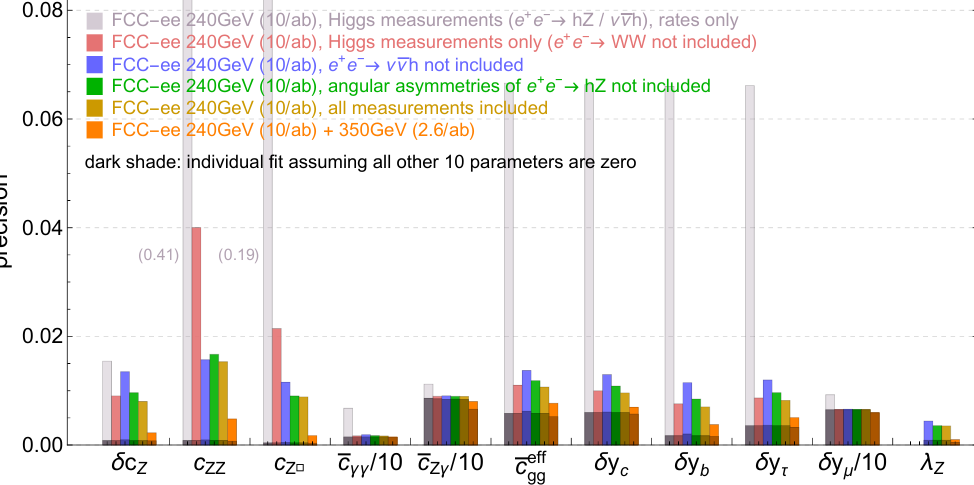
Figure 18 . Same as (cid:12)gure 8 but for